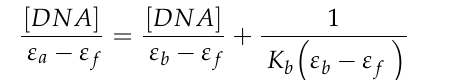
7 of 16 Figure 3. The four-molecule aggregate in 1 features hydroxyl-O–H … O(oxido) and charge-assisted N–H … O3 hydrogen bonds shown as orange and blue dashed lines, respectively. There are relatively few structural precedents for 1 in the crystallographic literature. Arguably the most closely related structure is that of [Et 3 NH][VO 2 L] where L is the